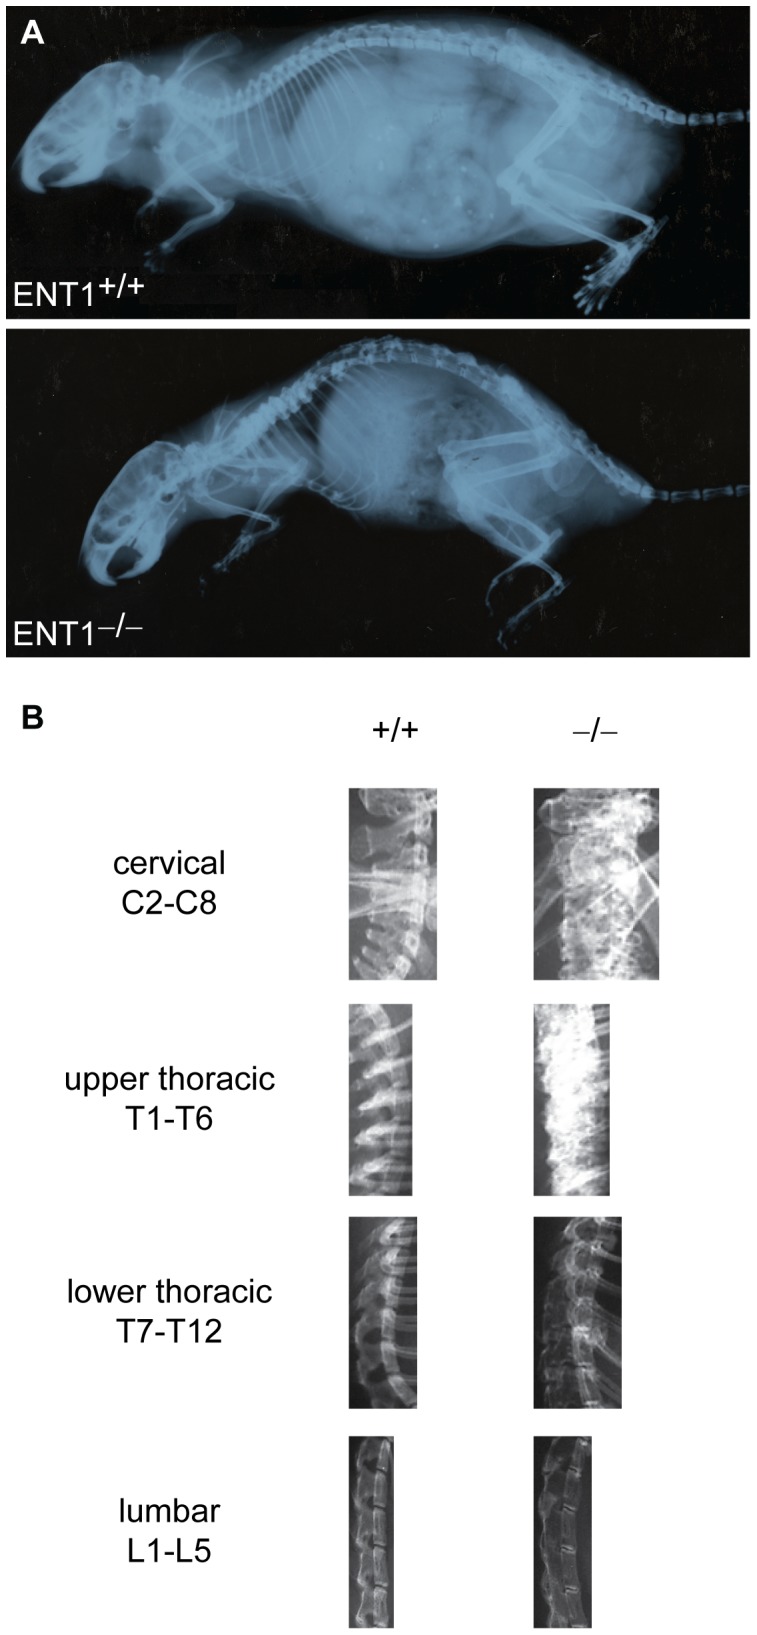
Bone density was assessed using X-ray.
A ENT1 wild-type and null mice were scanned with X-ray to investigate bone density. Representative X-ray radiographs from an ENT1 wild-type and null mice. B For analysis with NIH Image J software, the spinal column was divided into cervical (C2–7), upper thoracic (T1–T6), lower thoracic (T7–T12) and lumbar (L1–L5).